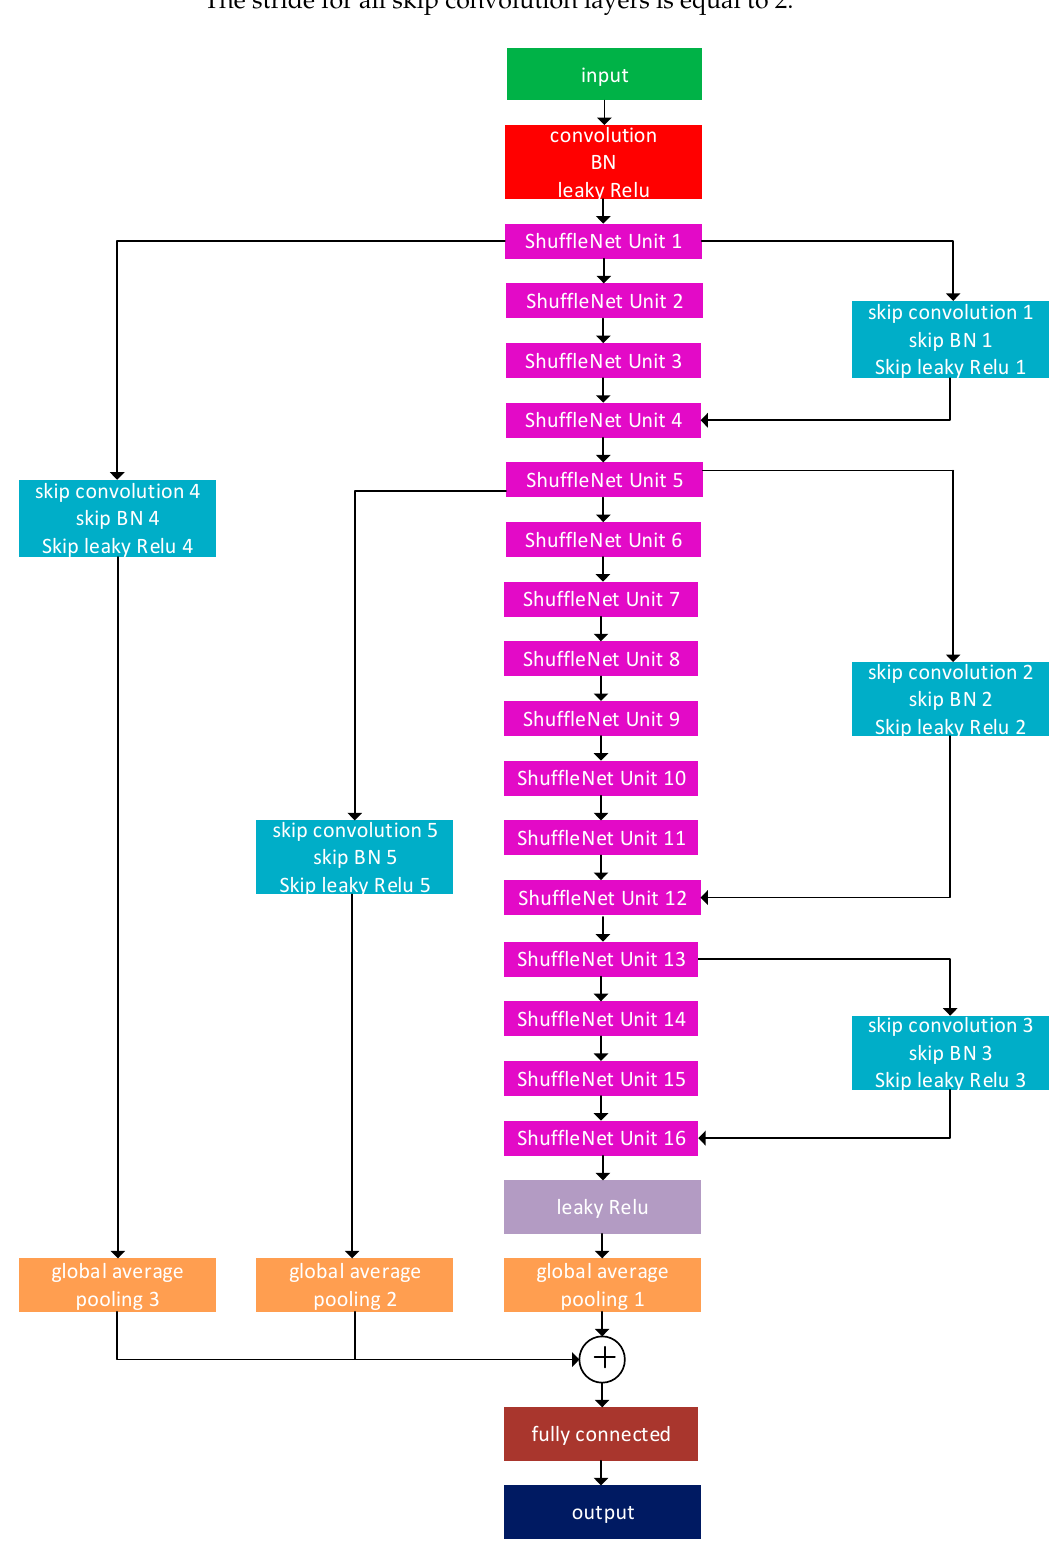
Figure 3. Proposed wide-ShuffleNet.